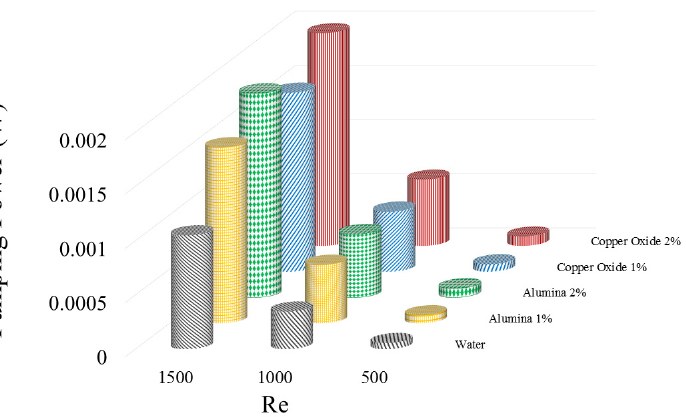
Figure 9. PP values required for moving the fluid having different Res for water fluid and water/Al 2 O 3 and water/CuO NFs at two various volume percentages.